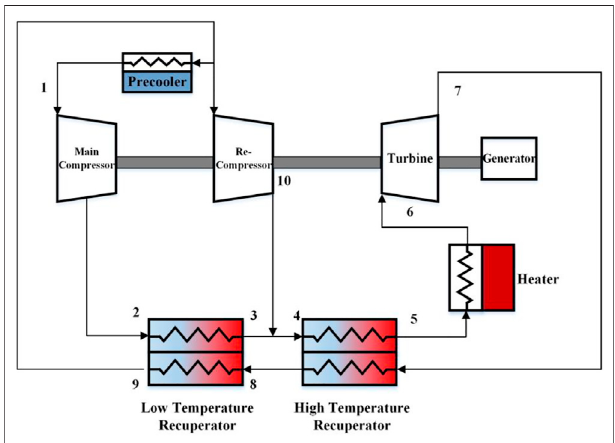
FIGURE 1 | SCO 2 recompression Brayton cycle